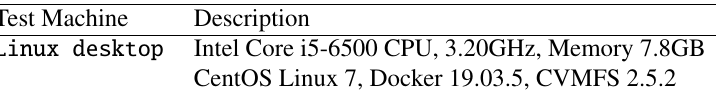
Table 1. Technical specifications of the testing host machine.